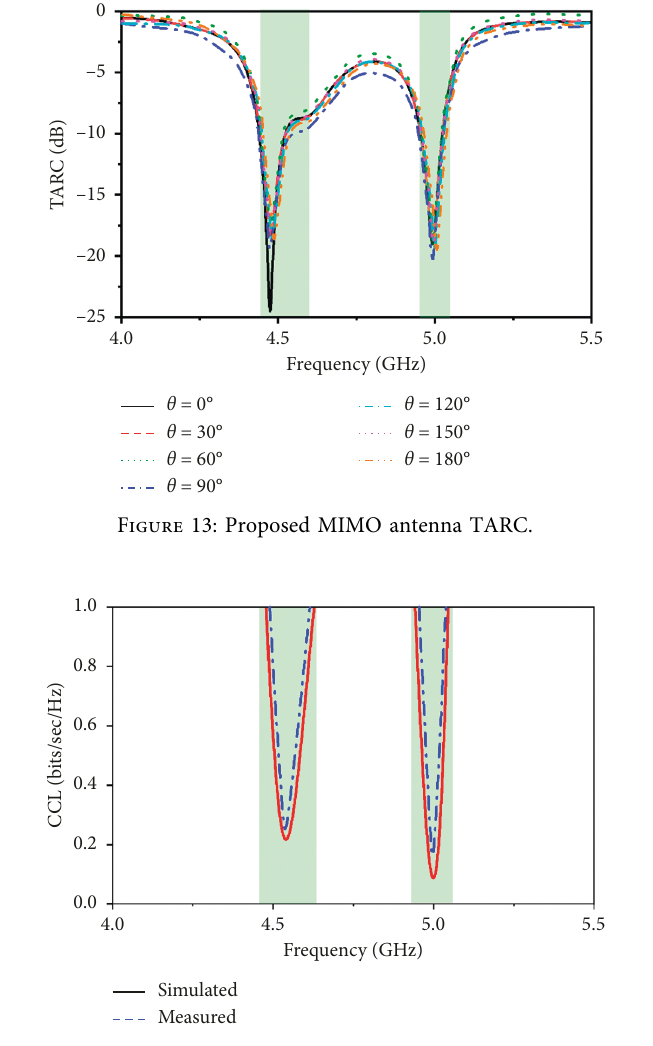
Figure 14: Proposed MIMO antenna CCL.